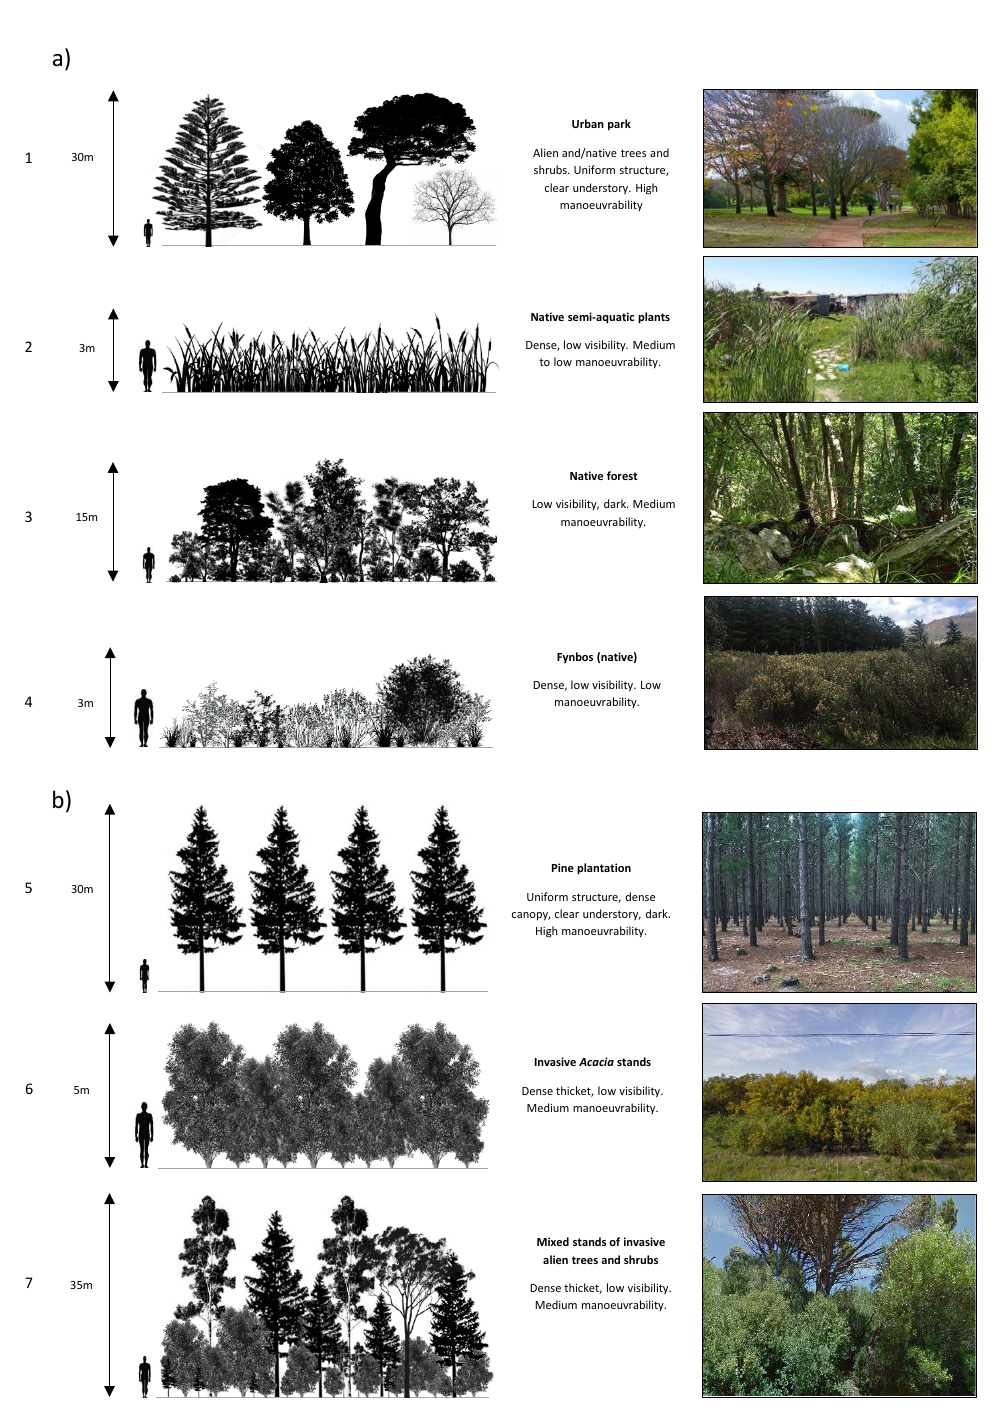
Figure 3. Conceptual scenarios of vegetation structure involving (a) alien and/or native and (b) alien invasive plants across Cape